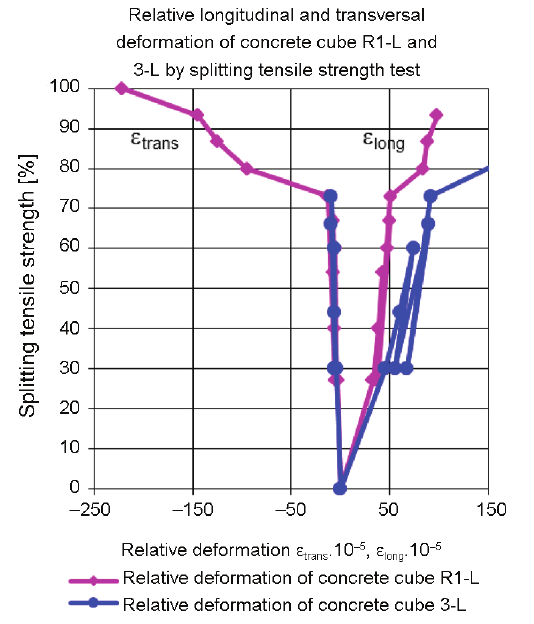
Fig. 8. Stress-strain diagram of concrete cube R1-L and 3-L under splitting tensile strength test